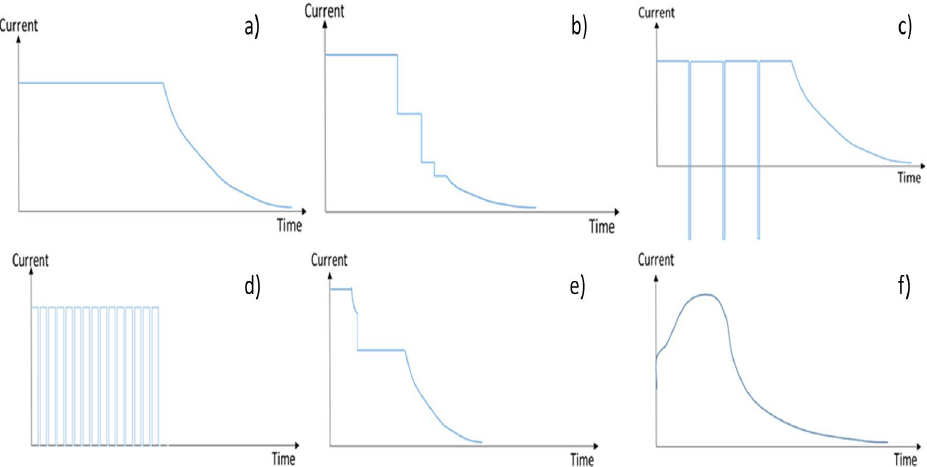
Figure 1. ( a ) Constant-Current–Constant-Voltage (CC-CV) charging profile; ( b ) Multi-stage constant-current (MCC) charging profile; ( c ) Constant-Current with negative pulse (CCNP) charging profile; ( d ) Pulse-current charging profile; ( e ) Boost- charging current profile; ( f ) Continuously Variable (VCP) current